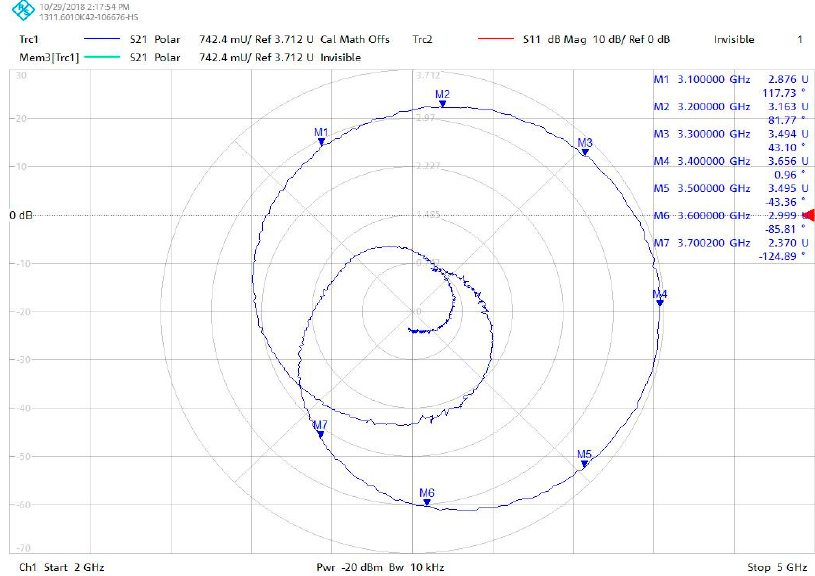
Figure 11. The measured gain phase of the Doherty power amplifier when both amplifiers are on.